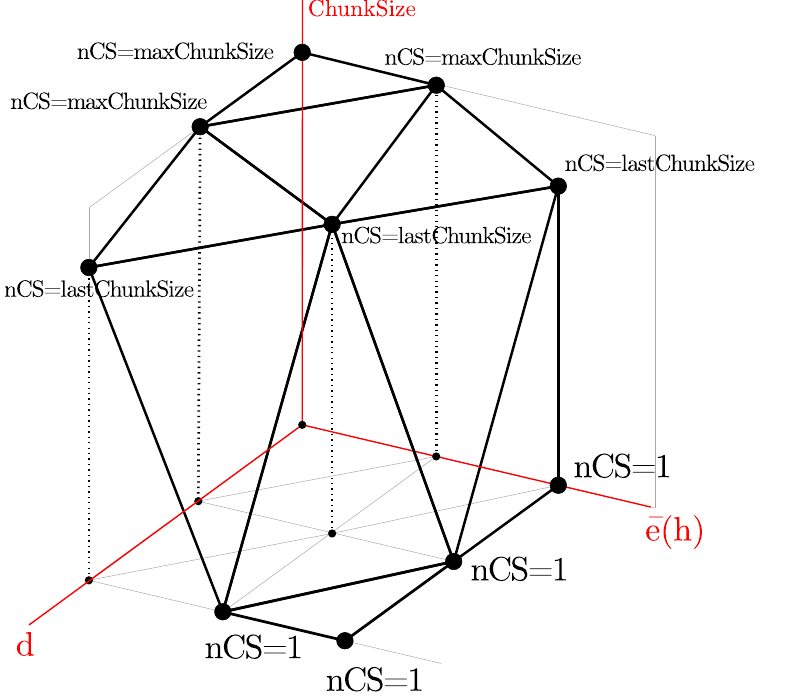
Fig 5. 3D representation of the Moody Scheduling function, that returns a value for nextChunkSize (nCS) provided the current lastChunkSize and depending on d and � e ð h Þ .